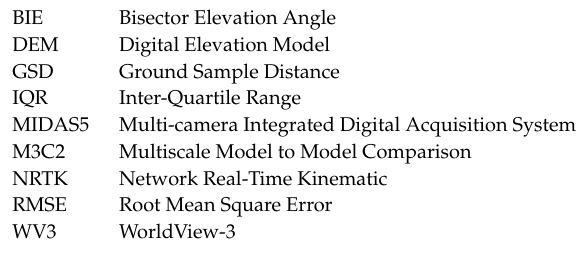
Table S1: Full statistics on M3C2 distance in the Centre